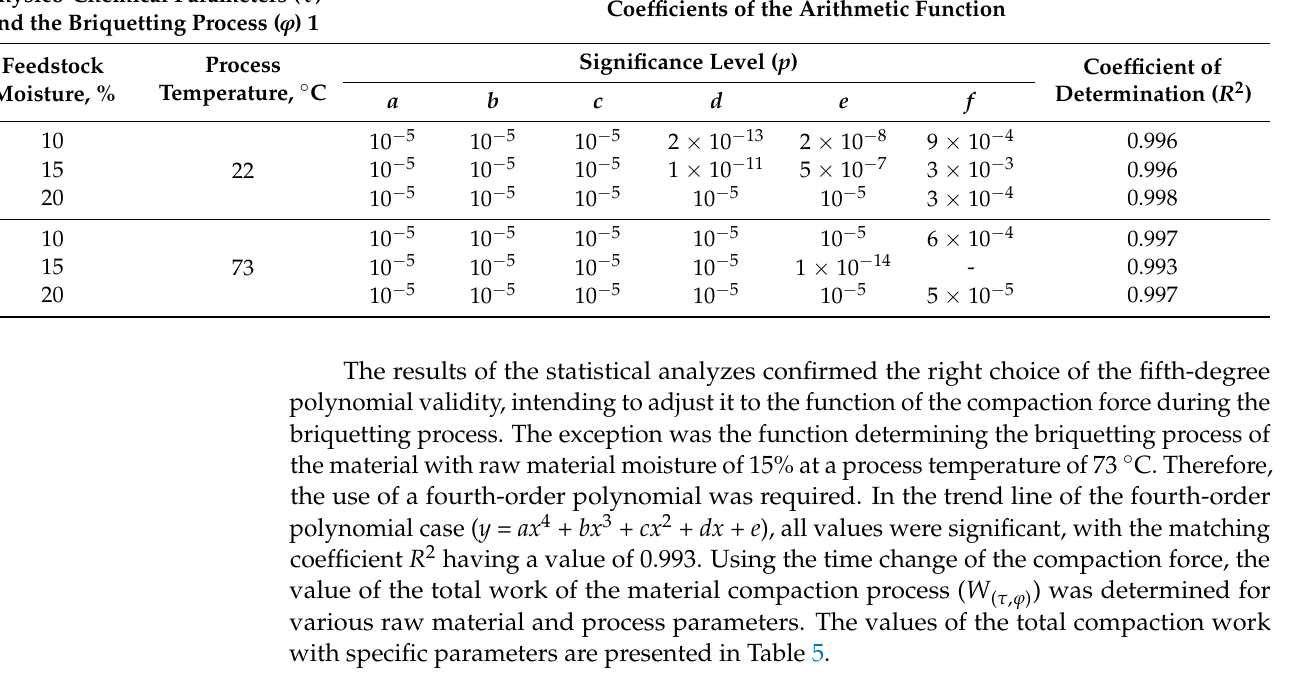
Table 4. Summary of the evaluation of the coefficients of the arithmetic function.